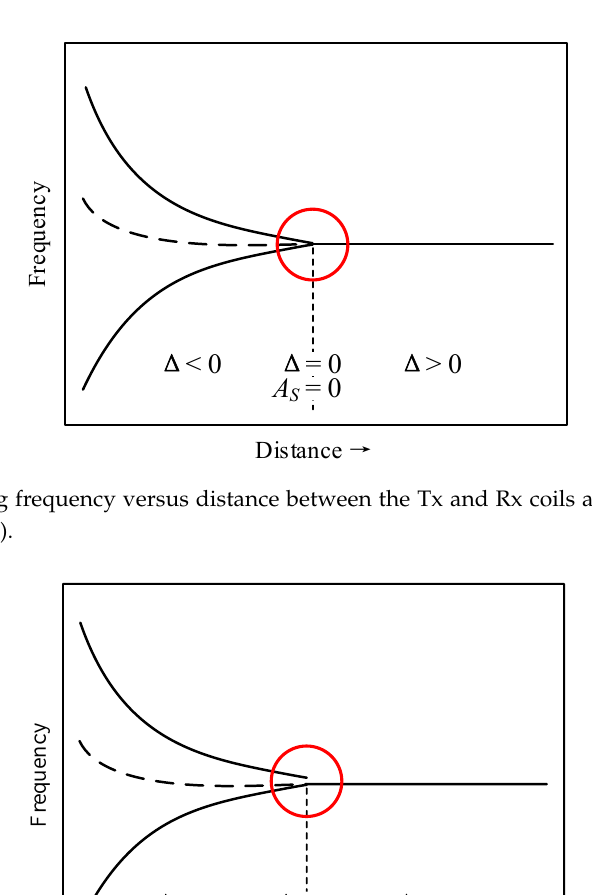
6 of 15 Figure 3. Operating frequency versus distance between the Tx and Rx coils at complete matching.